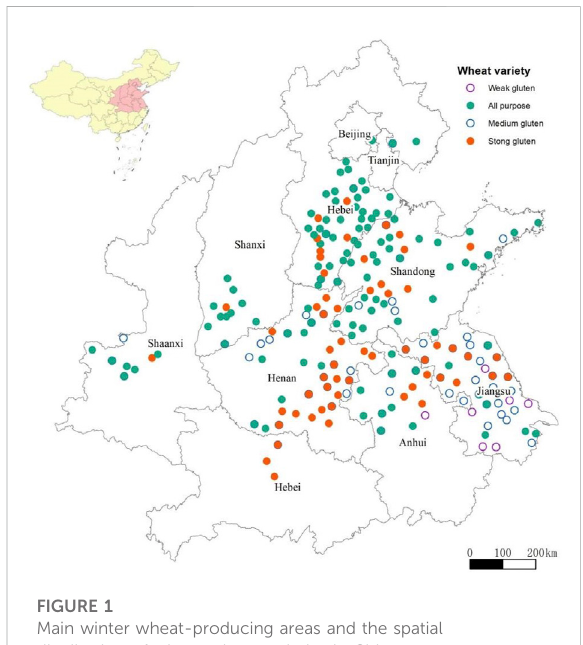
FIGURE 1 Main winter wheat-producing areas and the spatial distribution of winter wheat varieties in